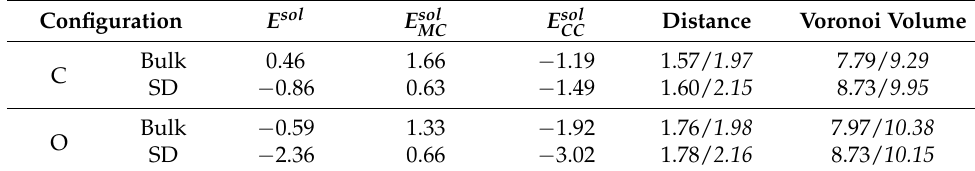
Table 1. The solution energy ( E sol in eV), mechanical contribution ( E sol ( E sol in eV) and corresponding 1NN C/O-Mo distance as well as Voronoi volumes (in Å 3 ) of interstitial CC C/O before ionic relaxations in Mo. For reference, the italicized values show the results after ionic